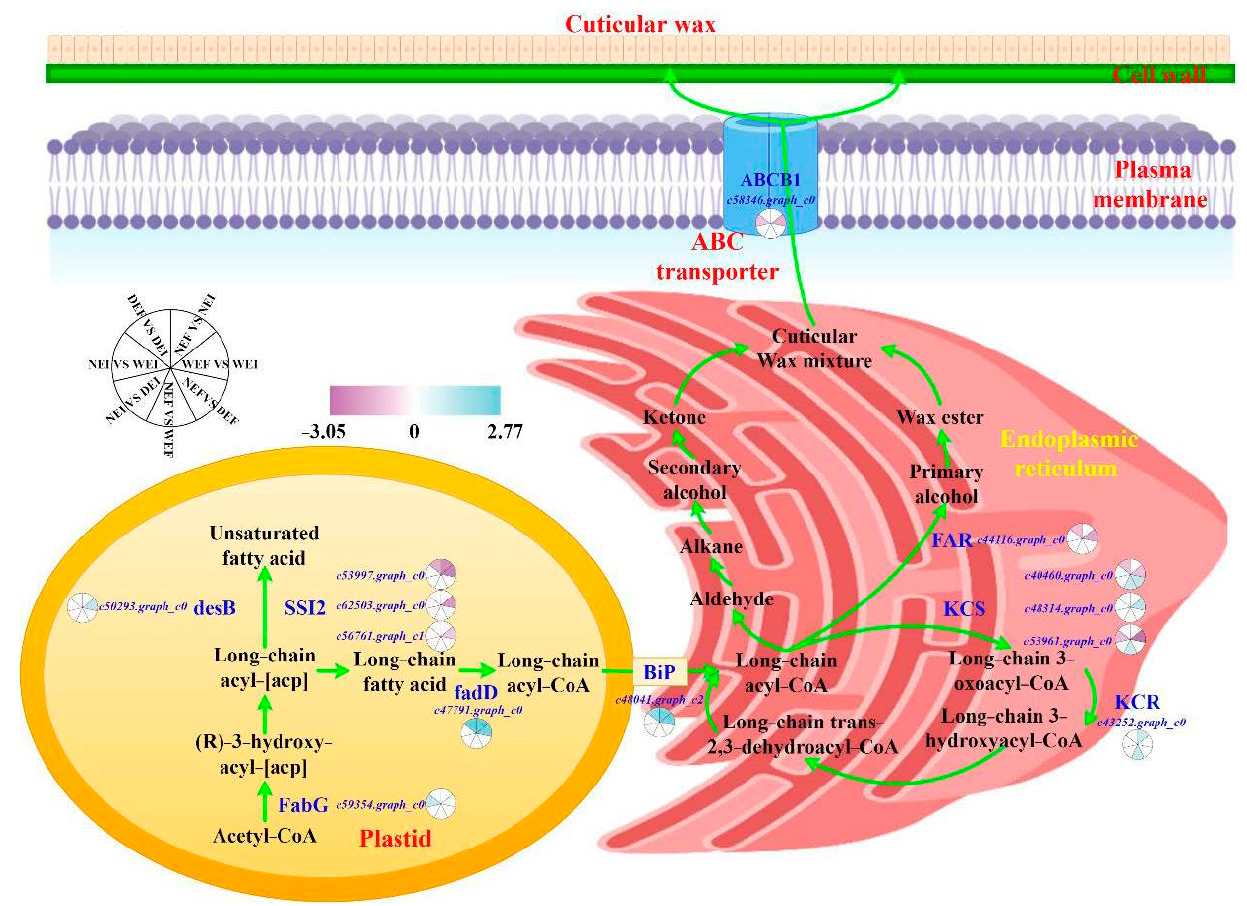
Figure 3. Proposed model for cuticular wax biosynthesis. Color bars ranging from purple to blue represent downregulation and upregulation in transcript expression. Gene ID is shown. Sectors of an equally divided circle represent comparisons between DEF and DEI, NEF and NEI, WEF and WEI, NEF and DEF, NEF and WEF, NEI and DEI, and NEI and WEI, respectively (D: drought, N: normal, W: well-watered, EI: endophyte-infected, and EF: endophyte-free).